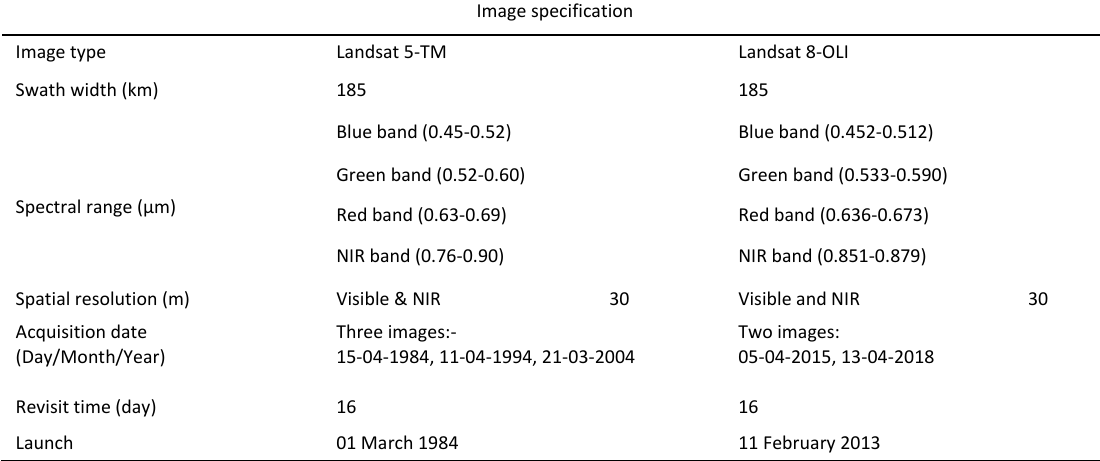
Table 1: Specification of Landsat TM and OLI bands, wavelengths and acquisition date Image specification